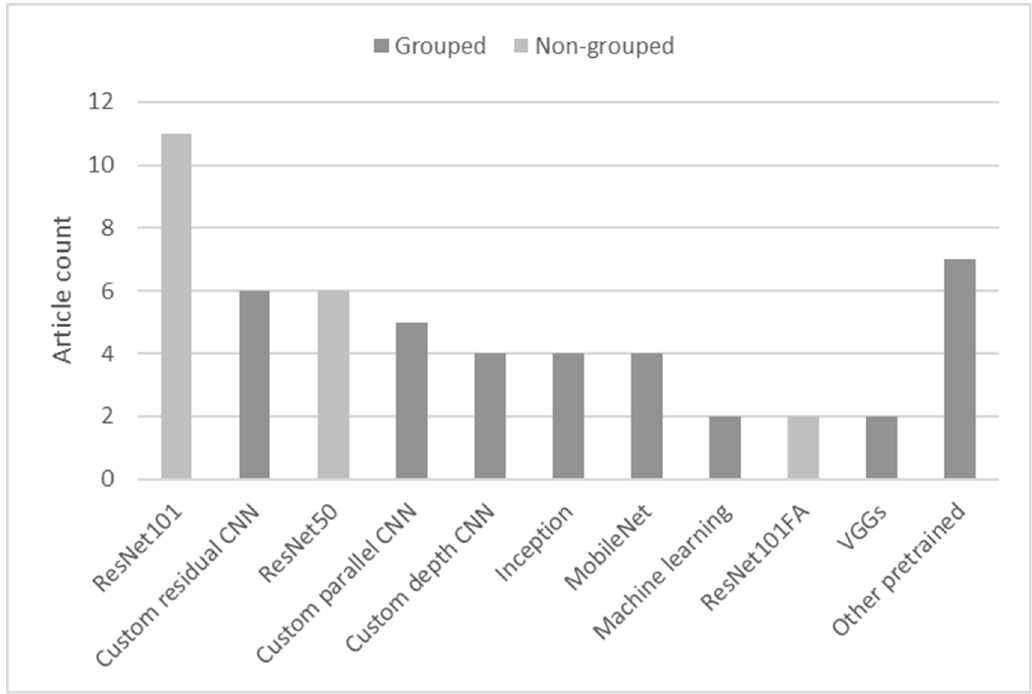
Figure 7. Backbone architecture usage.